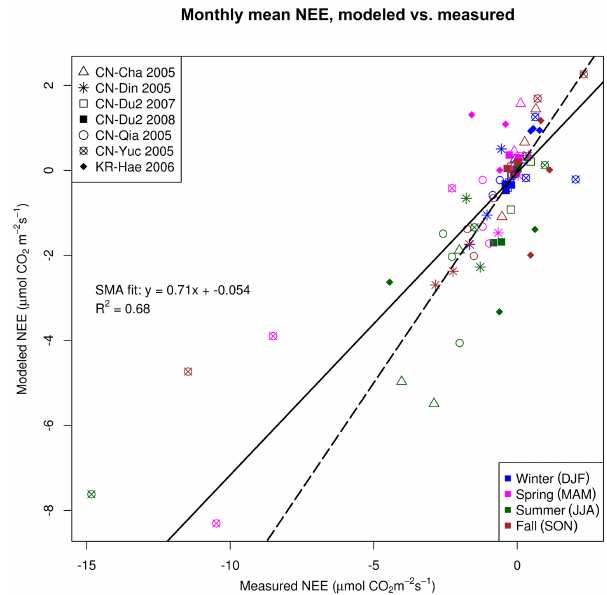
Figure 6. Monthly means of predicted (modeled) NEE vs. measured NEE at calibration sites, colored by season. Solid line is standard major axis (SMA) regression line; dashed line is 1 : 1.